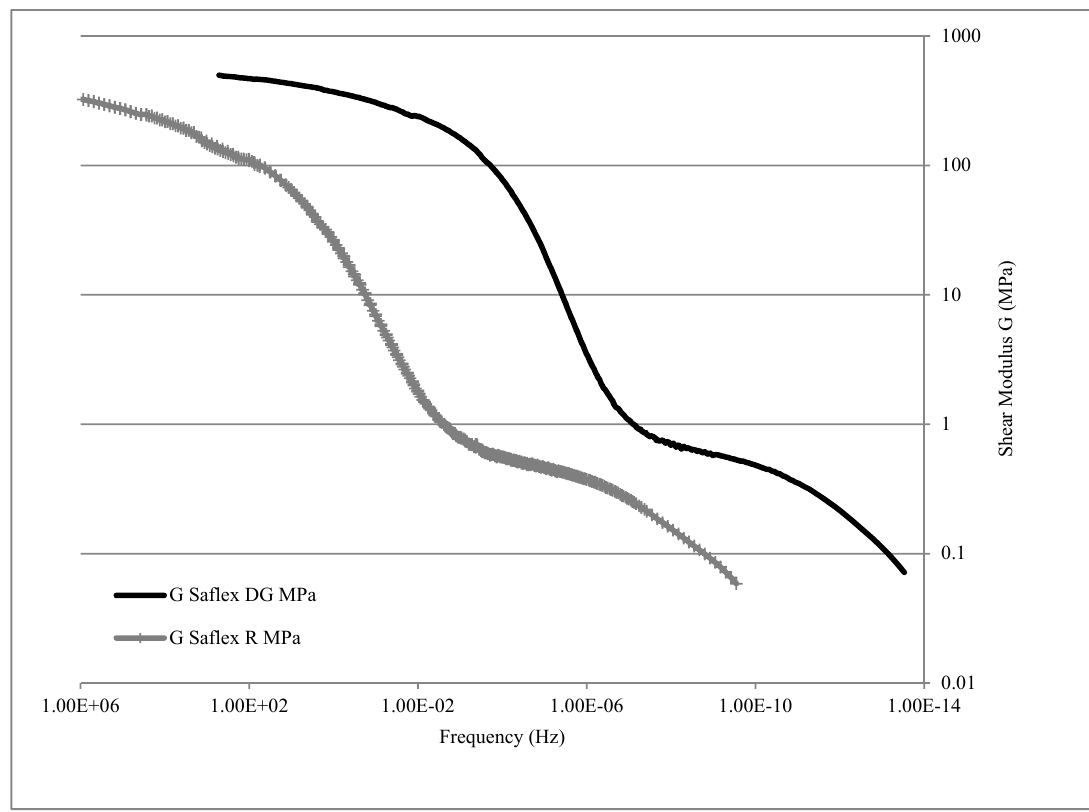
Fig. 4 Mastercurves at 20 o C of Standard and Structural PVB (Saflex ® RB41 and Saflex ® DG41